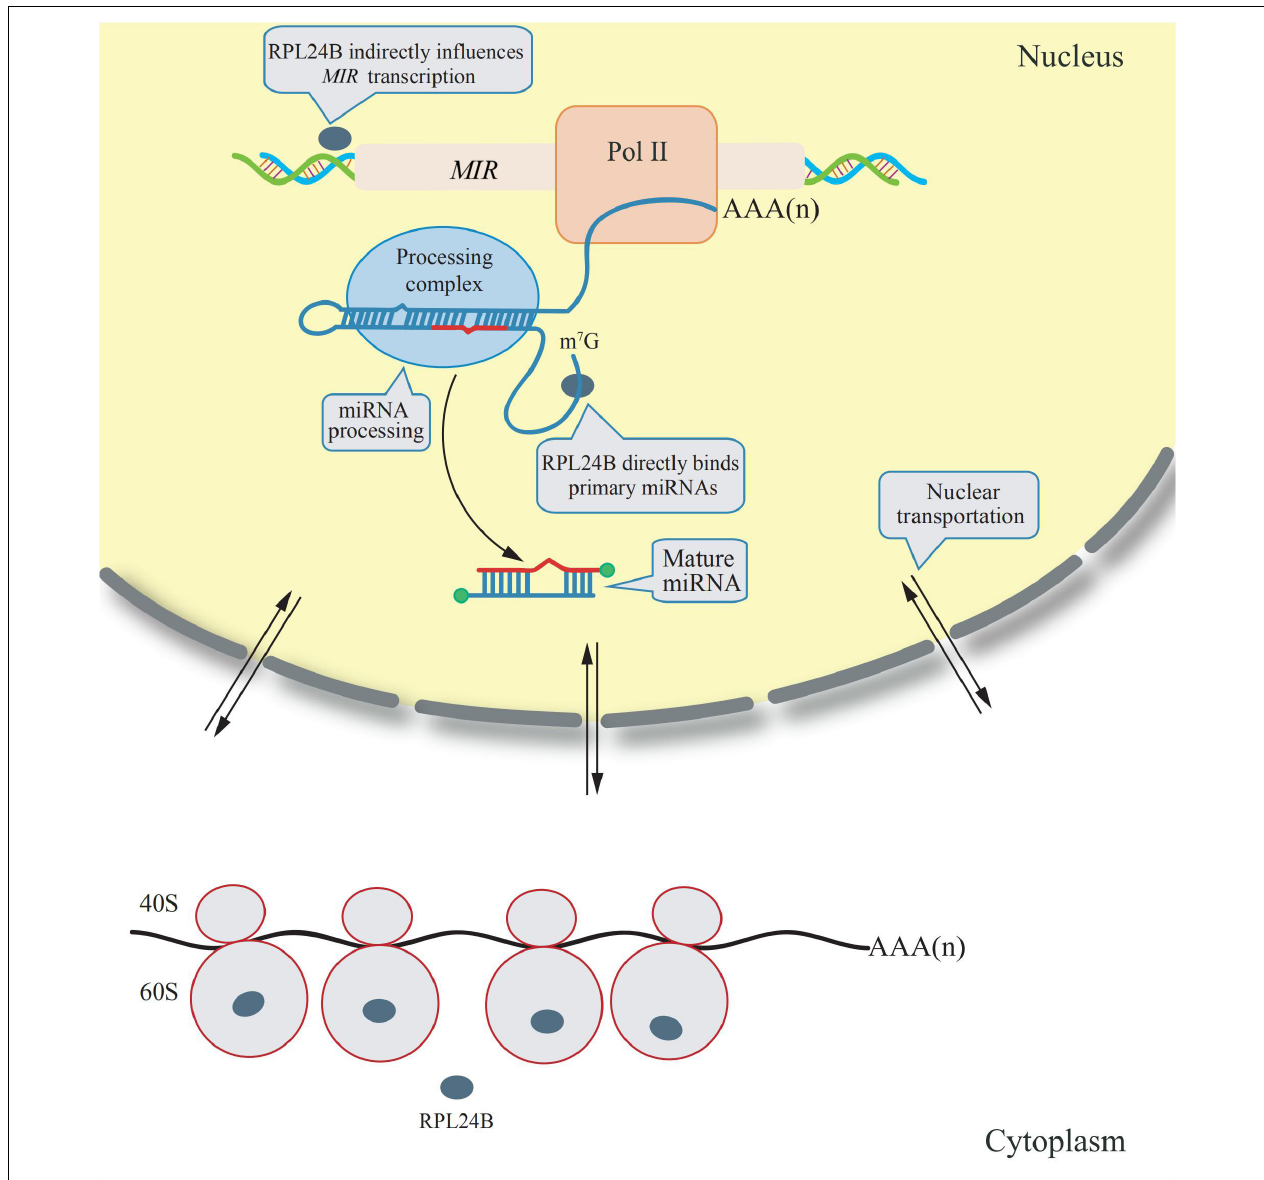
FIGURE 1 | Extraribosomal functions of RPL24B in Arabidopsis . RPL24B was translated by cytosolic ribsomes and a portion of RPL24B was translocated from the cytoplasm into the nucleus. In nucleus, RPL24B indirectly influences MIR transcription and directly binds primary miRNAs promoting their processing (Li et al.,